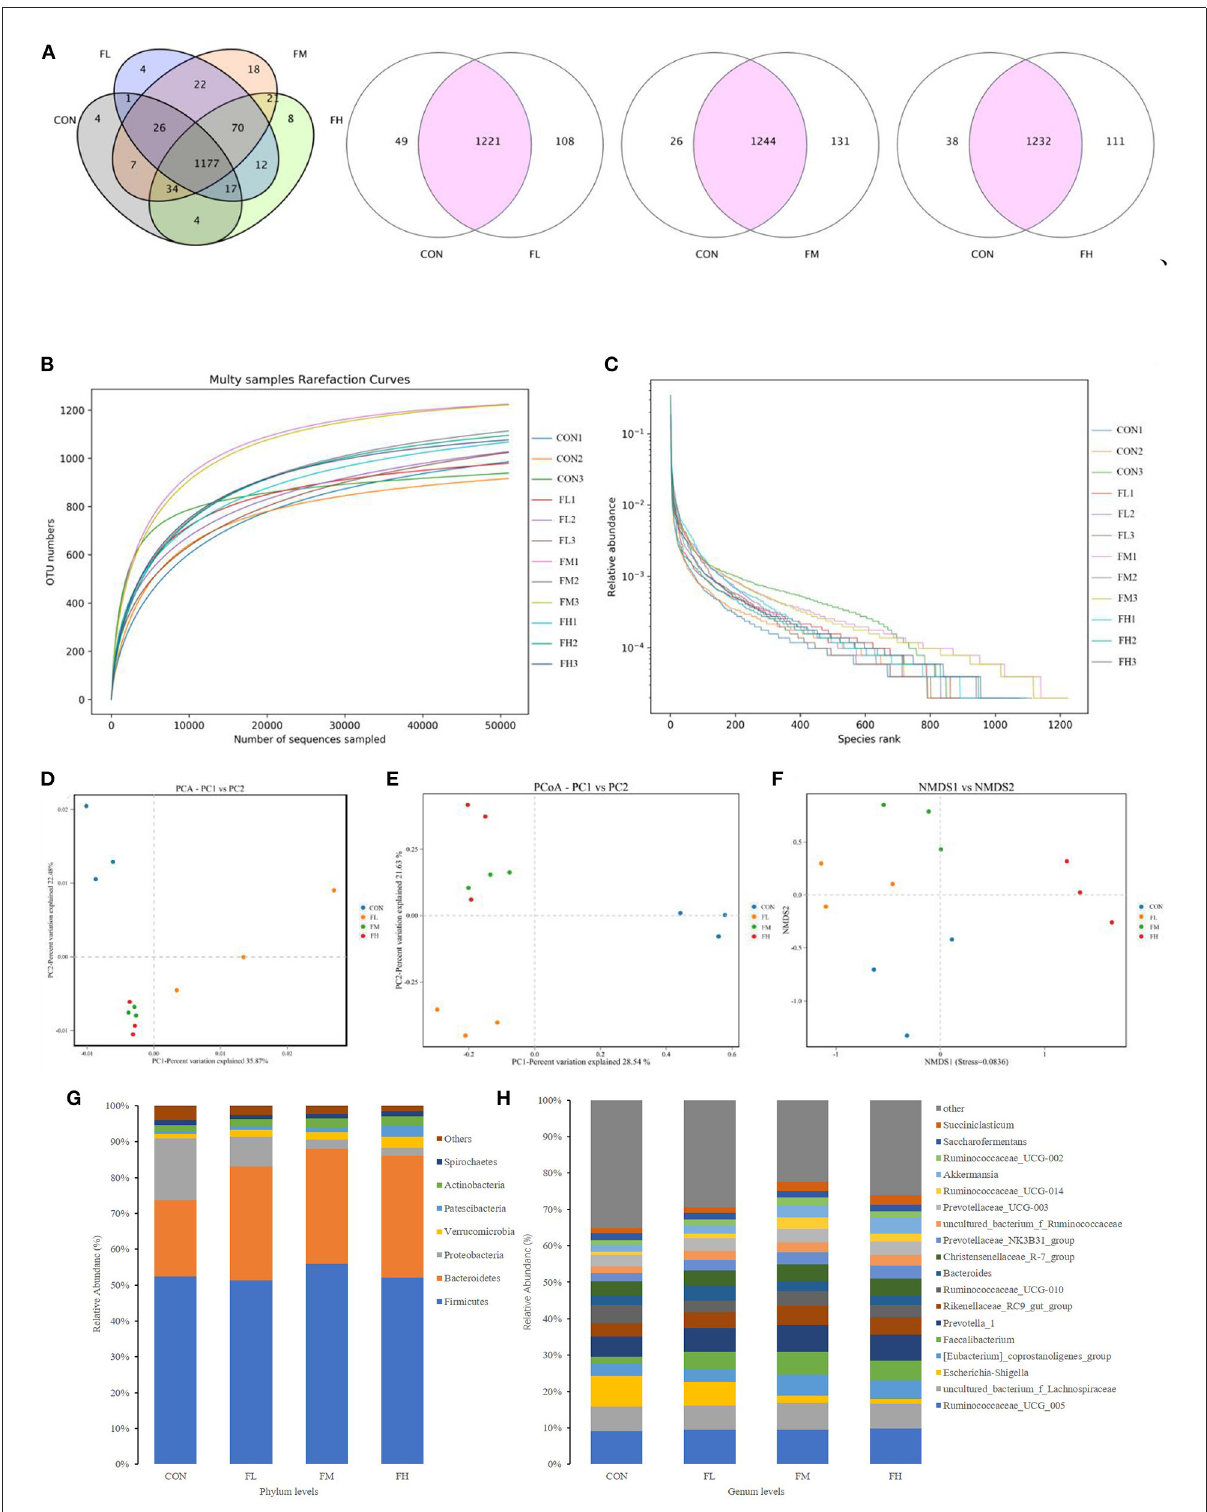
FIGURE7 Effects of fucoidan on the cecal microbiota of weaned lambs ( n = 3). (A) Venn diagram. (B,C) Correlation curves of species diversity. Multi-sample rarefaction curves (B) and the Rank-Abundance curves (C) . (D–F) Bate diversity analysis. (D) MetaStats analysis-based PCA analysis; (E) PCoA analysis using weighted UniFrac distances; (F) NMDS analysis. (G,H) Histograms showing the abundance of microbiota in the cecum at the phylum (left) and genus (right) levels. CON, control; FL, 0.1% fucoidan (DMI); FM, 0.3% fucoidan (DMI); FH, 0.6% fucoidan